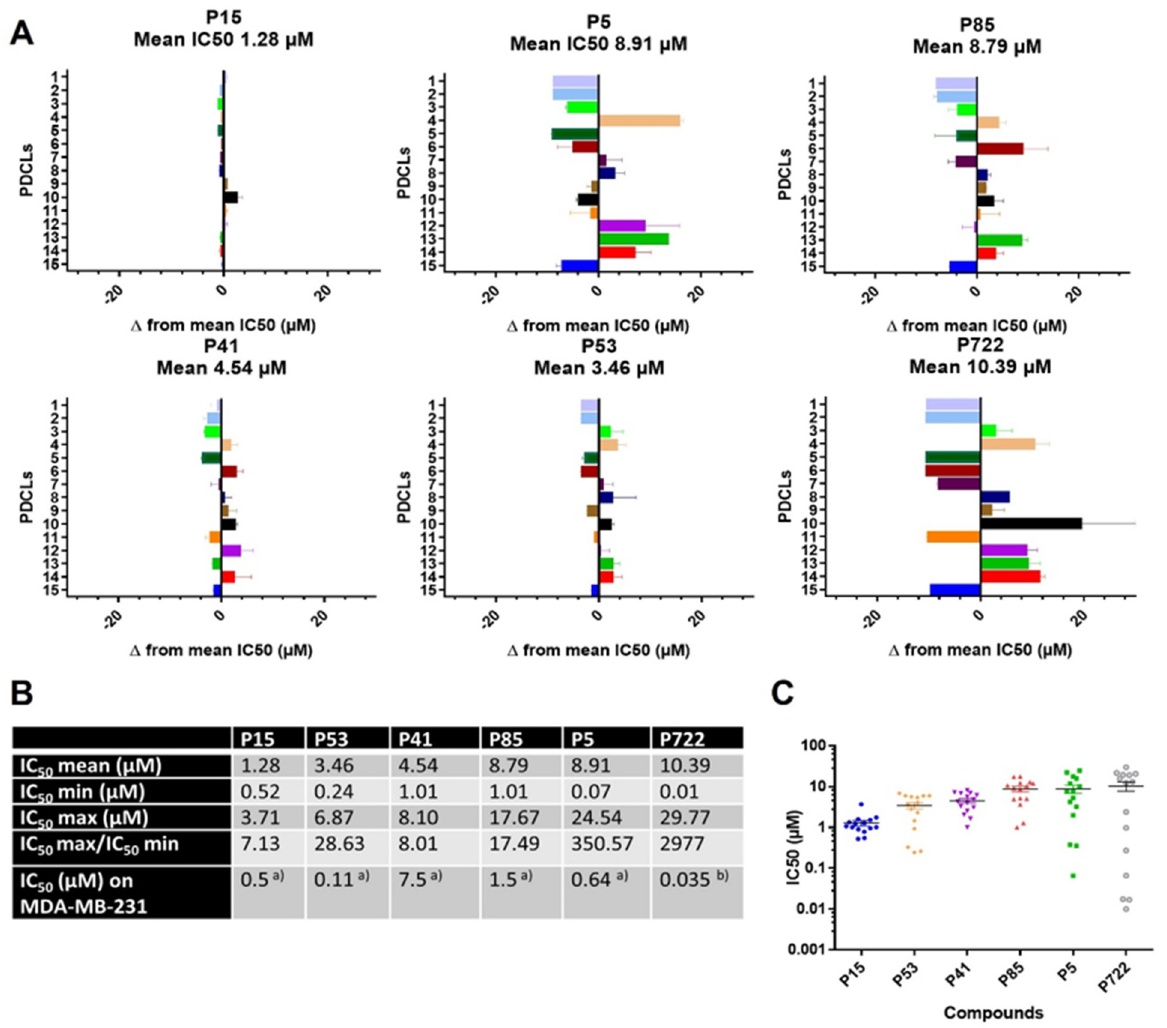
Figure 2. Ferrocifens induce diverse impacts on PDCL viability according to the genetic context. ( A ) For each compound, differences from the mean IC 50 values obtained for all PDCLs. ( B ) Mean IC 50 values obtained for each compound for all PDCLs, highest (IC 50 max) and lowest (IC 50 min) values and their ratio. (a) IC 50 values from [15] (a) from [28] (b) for MDA-MB-231 (hormone-independent breast cancer cells). ( C ) For each compound, the graphical representation of IC 50 values was obtained for all PDCLs and their range.